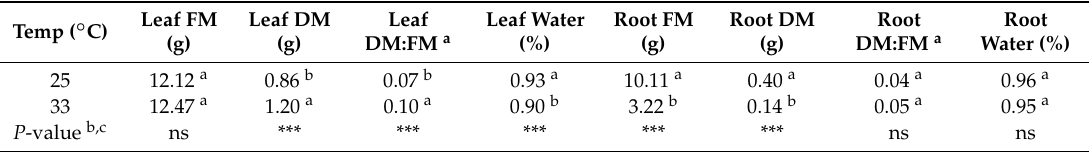
Table 1. The effect of grow chamber temperature on red, ‘Lollo’ lettuce shoot and root fresh mass, dry mass, DM:FM ratio, and water